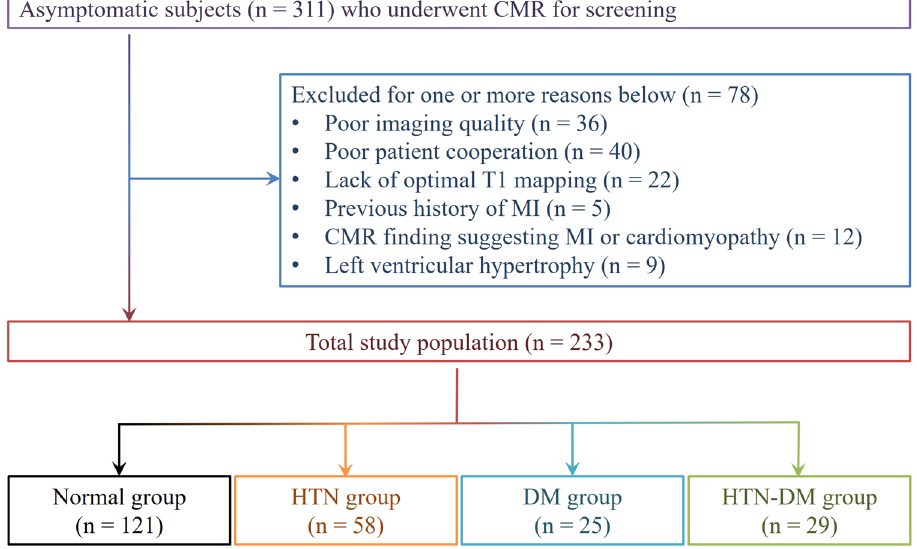
Figure 4. Flow chart of study population enrollment. The total study population was divided into four groups according to cardiovascular risk factors. The control group was defined as subjects who did not have